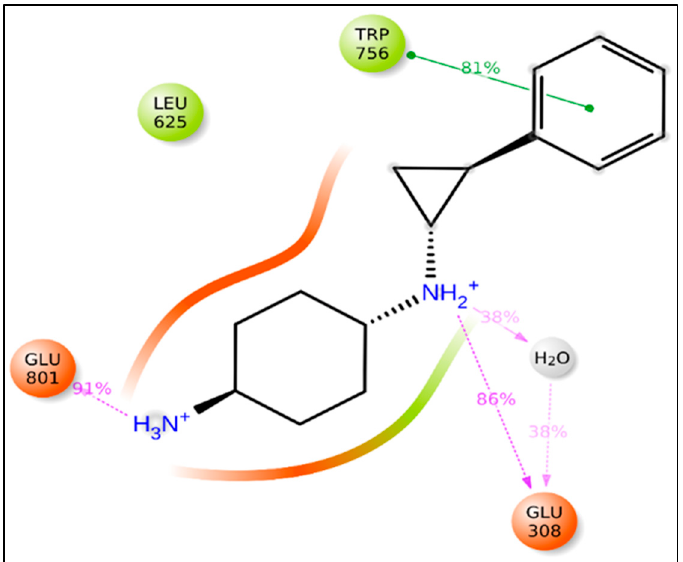
Figure 9. Depiction of the involvement of the molecular descriptor fdonsp3C2B in the LSD1-Compound 1 interactions during MD simulations.